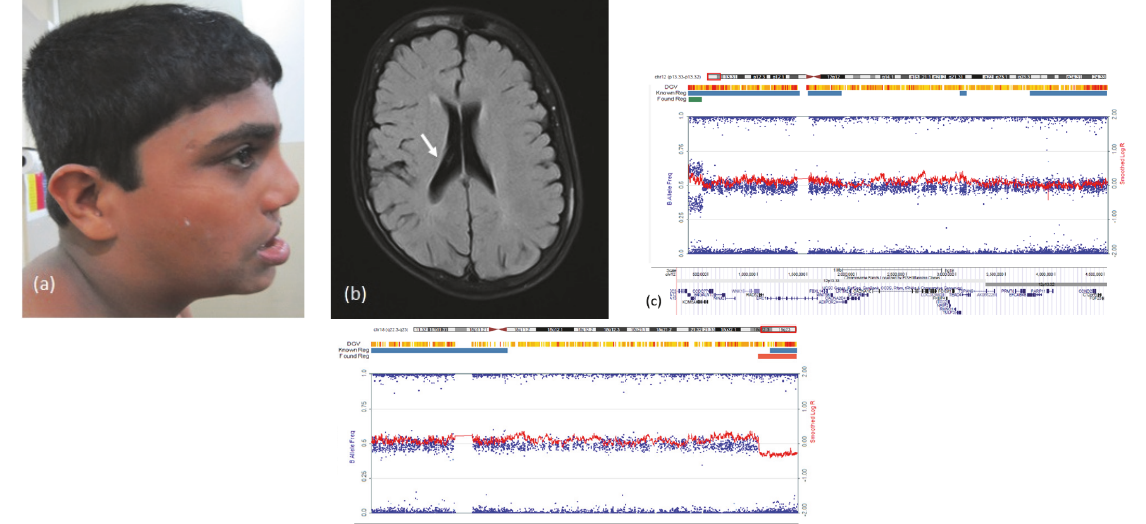
mild [16, 17]. Therefore, the features seen in the proband